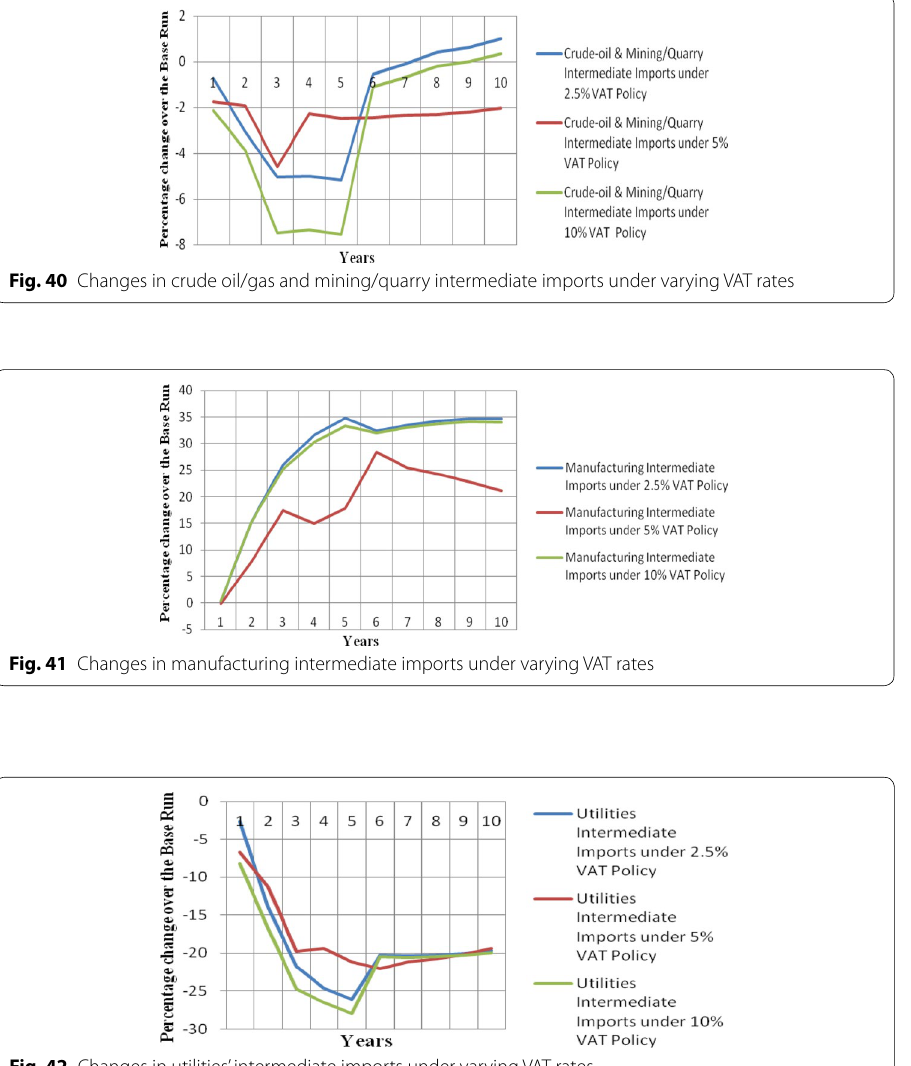
Fig. 42 Changes in utilities’ intermediate imports under varying VAT